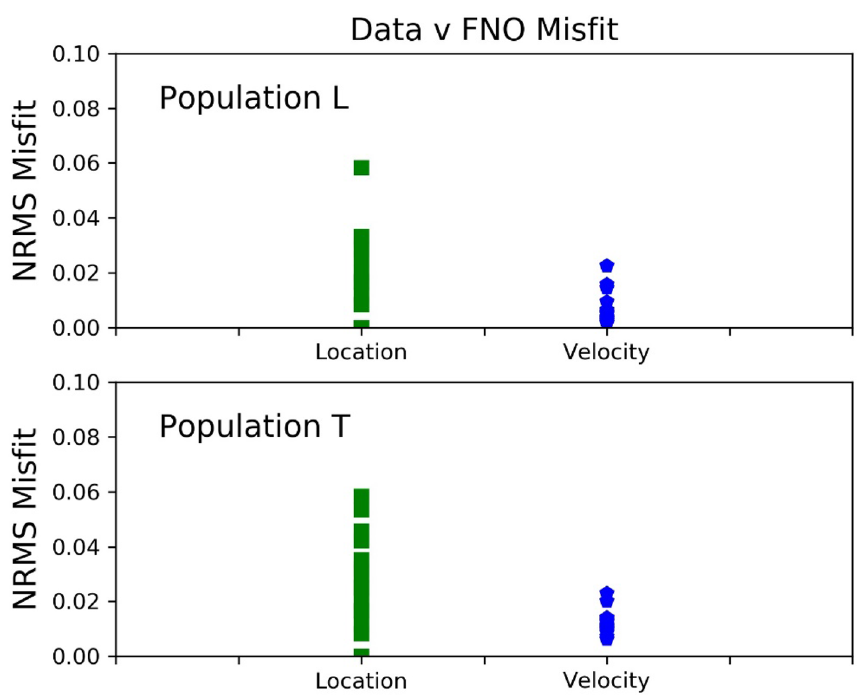
Figure 7. The normalised RMS misfit is shown for 20 different inversions using unseen samples from the population L in the upper panel and population T in the lower panel. 15% white noise was added to the input seismic traces during training. The velocity models are well resolved by the FNO inversions as are the source locations. All 20 inversions are for different previously unseen models with the same statistical properties as the training velocity model